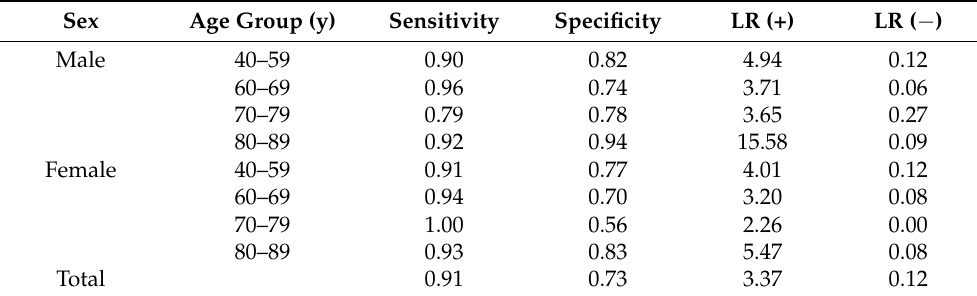
Table 4. Diagnostic characteristics of the screening tool combining grip and release test and grip